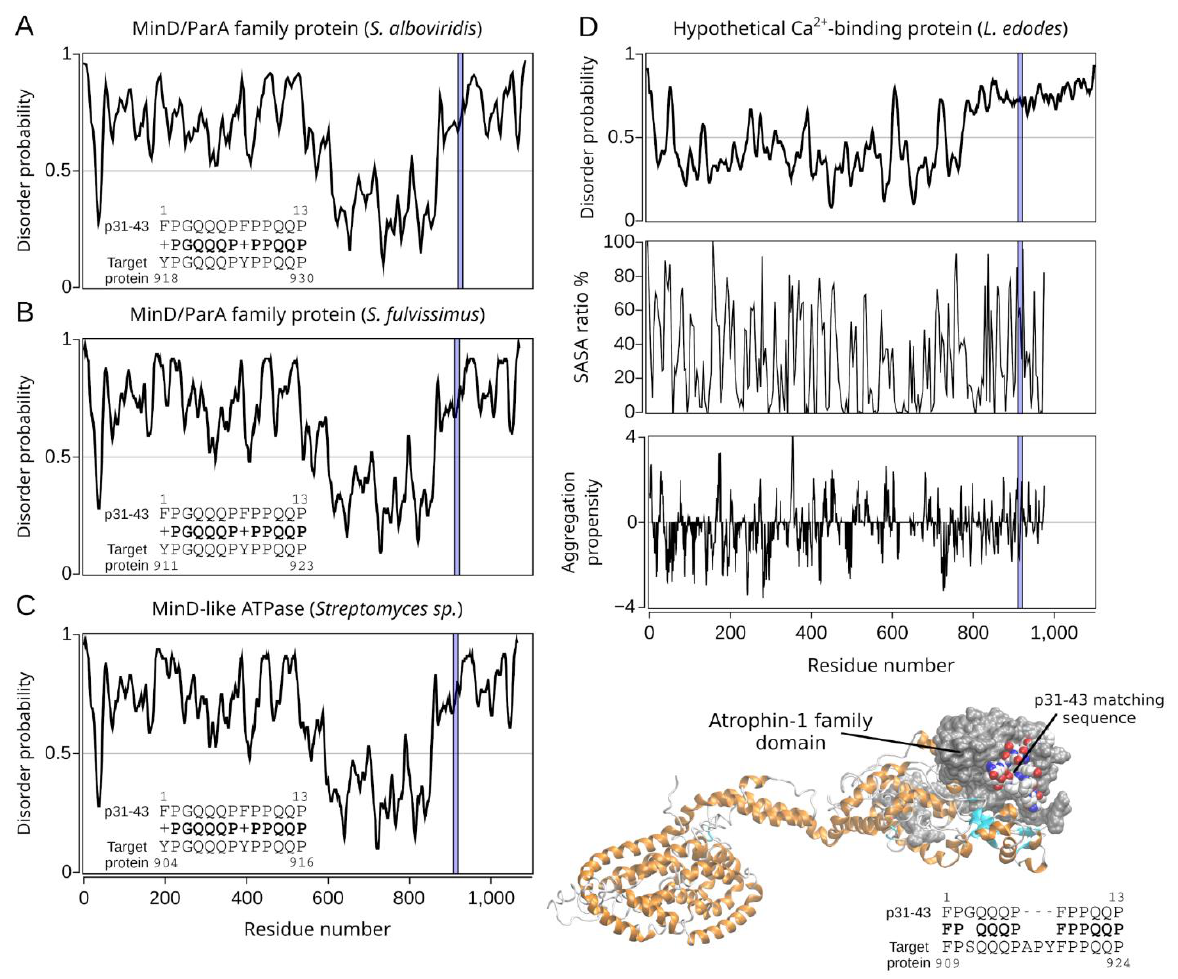
Figure 5. Sequence and structural characterization of target proteins found by BLASTp search of the p31-43 peptide. In all cases, the regions sharing high sequence similarity with the p31-43 sequence are shown in a blue box. The sequence-based disorder prediction for the MinD/ParA proteins from Streptomyces alboviridis and Streptomyces fulvissimus , the MinD-like ATPase from Streptomyces sp. ScaeMP-e48, and the hypothetical calcium-binding protein from Lentinula edodes , are shown in panels ( A – D ), respectively, setting a 5% threshold (false positive rate, gray horizontal line). For the latter, the percentage of solvent-accessible surface area (SASA) per residue and aggregation propensity are shown alongside the target model at the bottom right. The atrophin-1 domain is represented in surface (gray), and the region with high sequence similarity to the p31-43 sequence of α-2-gliadin is represented in van der Waals. In addition, the sequence alignment with the target protein is shown.